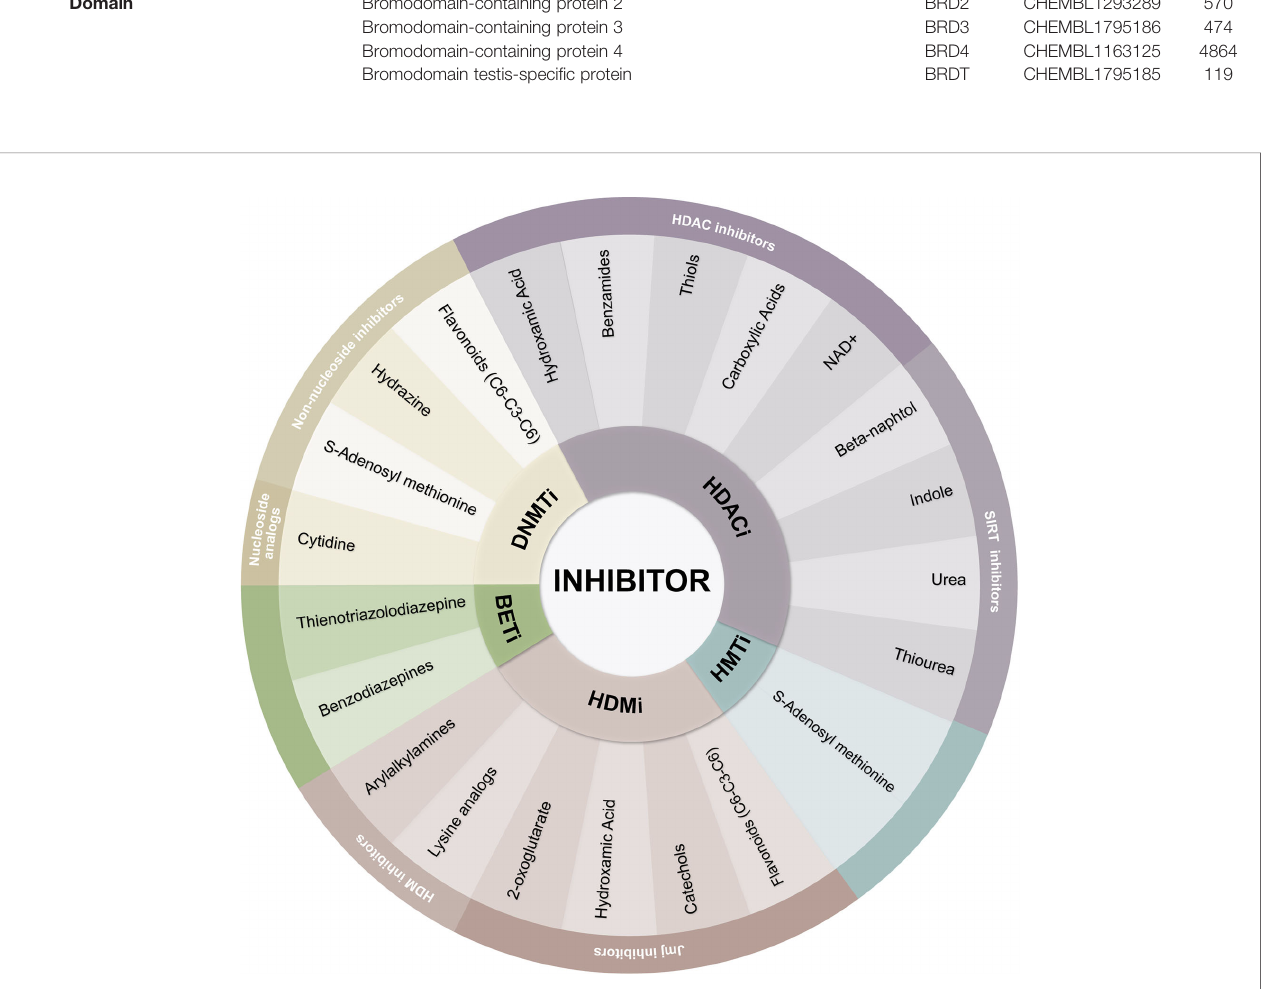
FIGURE 3 | Classi fi cation of epigenetic inhibitors. Epigenetic inhibitors are classi fi ed as DNMTi, HDACi, HMTi, HDMI, and BETi. The chemical nature of each inhibitor de fi nes the af fi nity of its